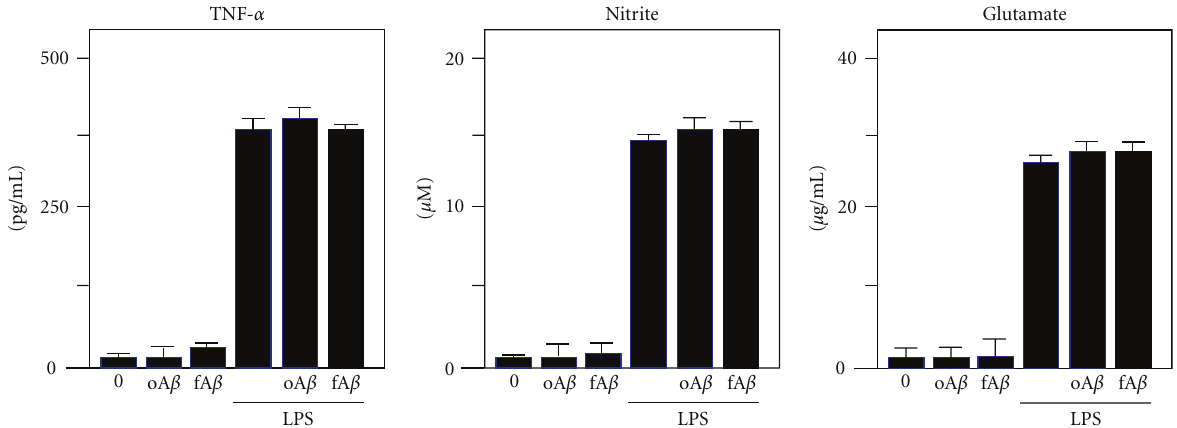
Figure 2: Inflammatory molecules produced by A β - or LPS-activated microglia. In primary microglial culture, administration of 5 μ M oA β 42 or 5 μ M fA β 42 for 24h does not induce the production of neurotoxic mediators such as TNF- α , glutamate, or nitrite, a stable breakdown product of NO. While microglia activated with 1 μ g/mL LPS produce these molecules, both oA β 42 and fA β 42 do not enhance the